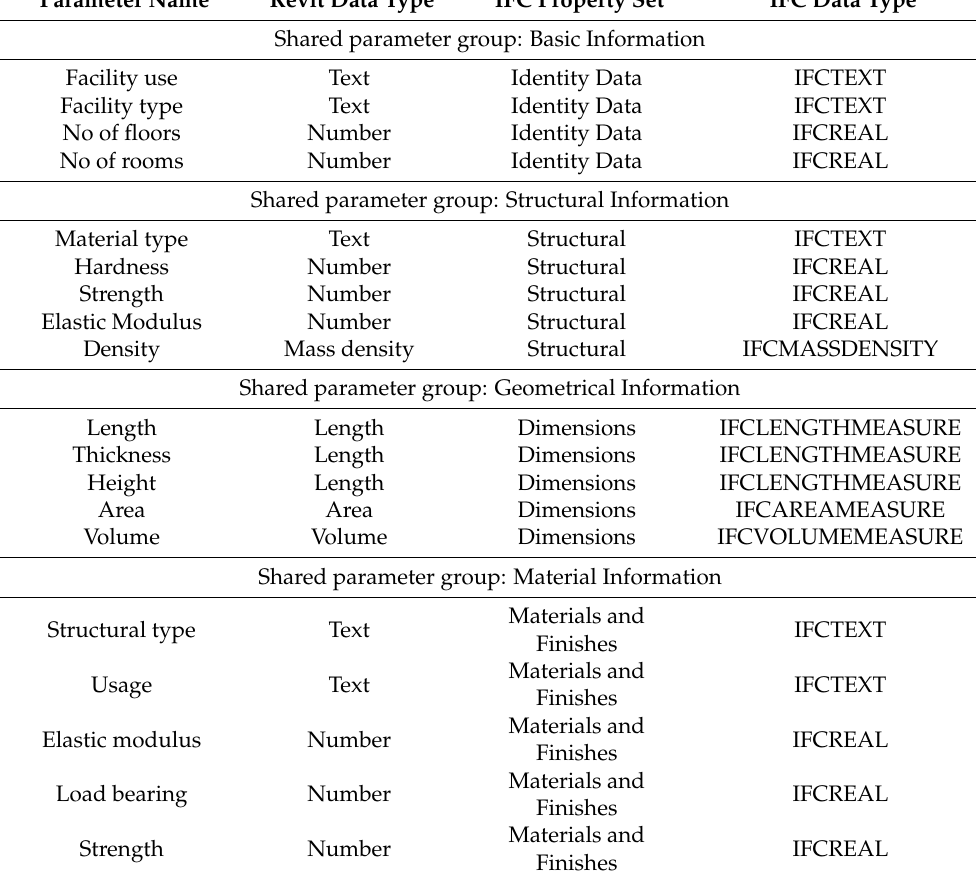
Figure 12. FM information with the heritage BIM element. Table 1. Mapping of heritage component information into IFC